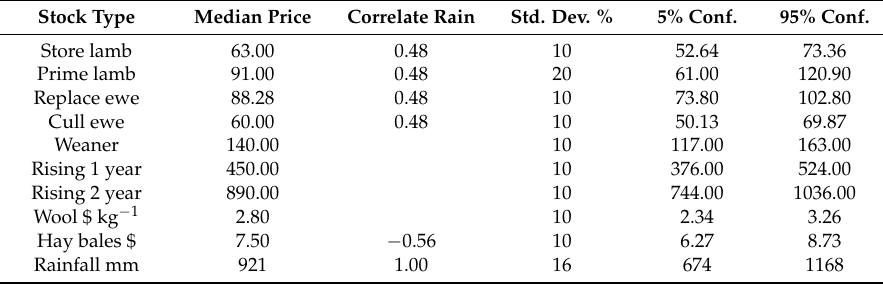
Table 1. Modelling price inputs, correlation to rainfall, and 5–95% confidence levels for a sheep station in lower Western North island of New Zealand (LWNI) using a normal distribution.